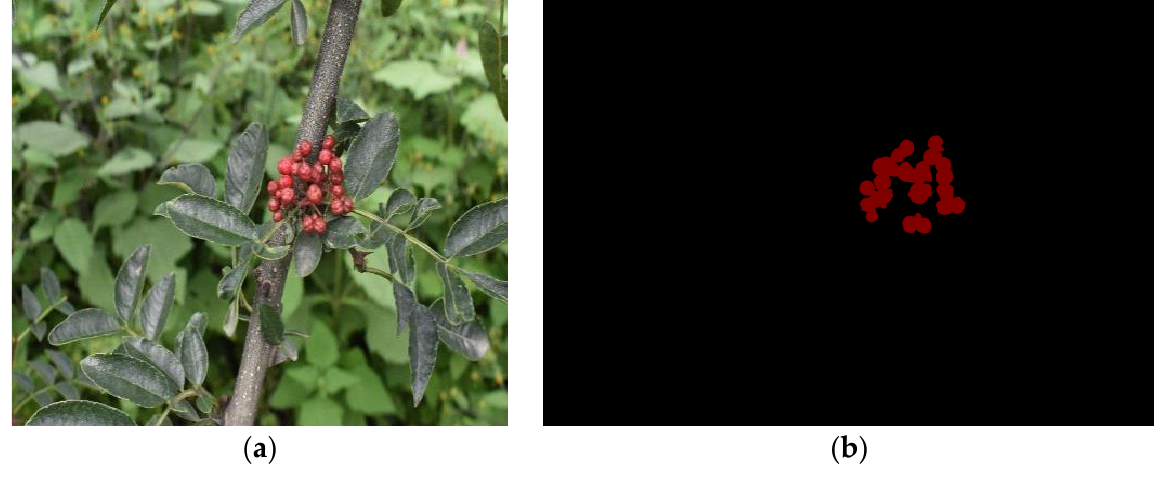
Figure 3. ( a ) Before marking; ( b ) after marking